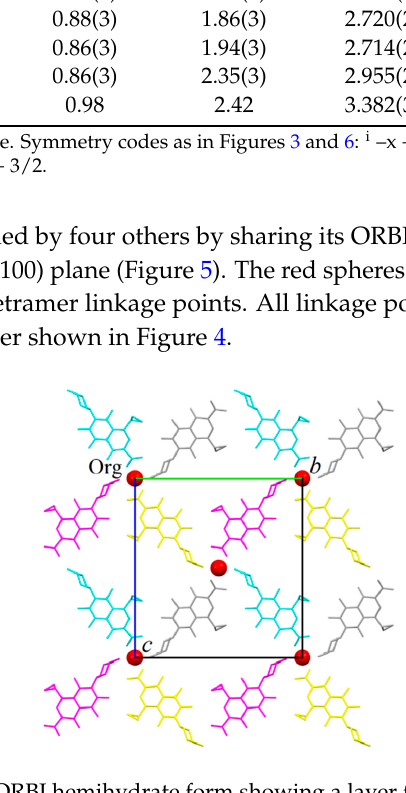
Table 2. Hydrogen bonds for ORBI hemihydrate form (Å and °), where D = donor and A = acceptor.